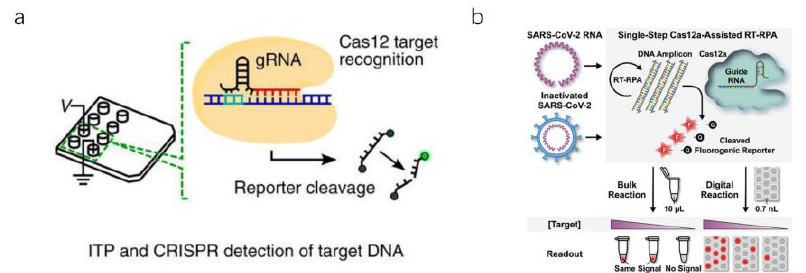
Figure 8. Several essential microfluidic chips for detecting SARS-CoV-2 using CRISPR–Cas. ( a ) Electric-field-mediated microfluidic detection device [19]. ( b ) Schematic diagram of digital